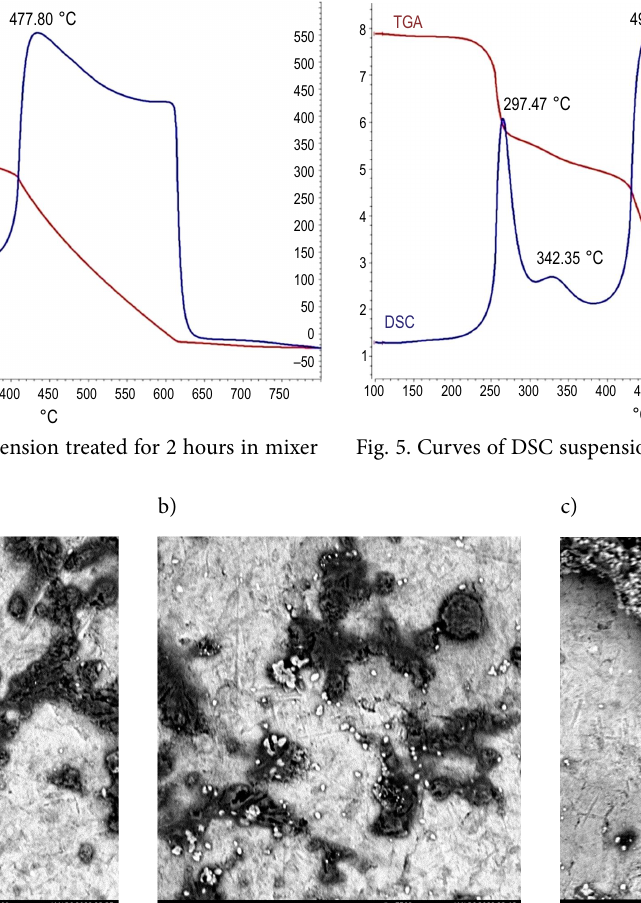
Fig. 6. Microstructure of suspension treated for: a – 2 hours; b – 4 hours; c – 10 hours at